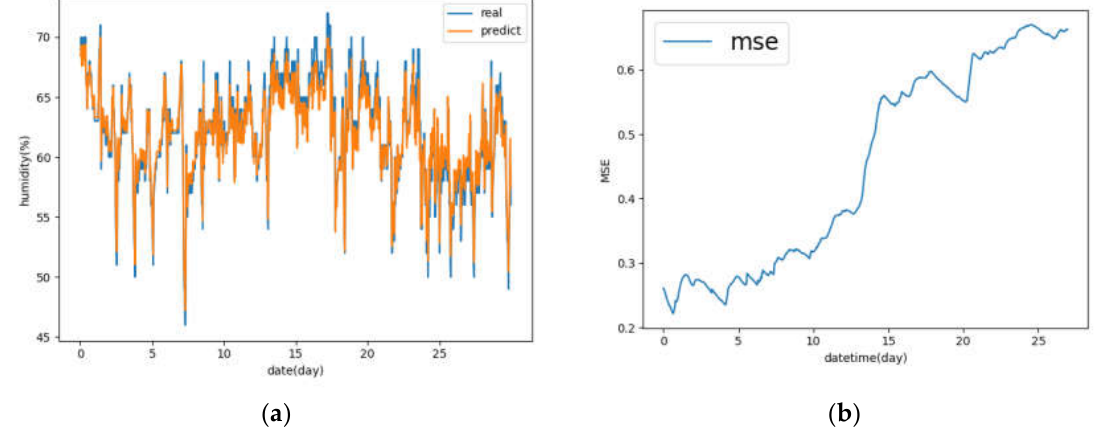
Figure 12. Predicted results of humidity for 30 consecutive days. Figure ( a ) is a graph of actual humidity and predicted humidity, and Figure ( b ) is the mean square error of actual humidity and predicted humidity. Table 3. The maximum error of temperature and humidity in different time